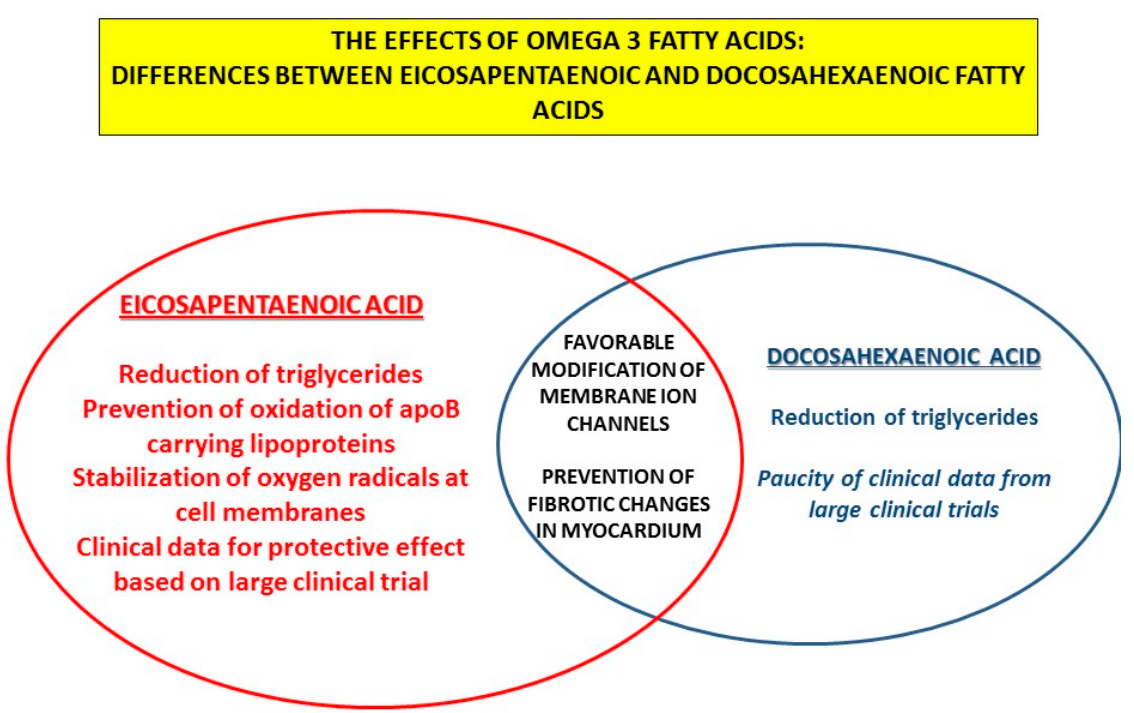
Figure 5. The effects of omega-3 fatty acids: differences and similarities between eicosapentaenoic and docosahexaenoic fatty acids.